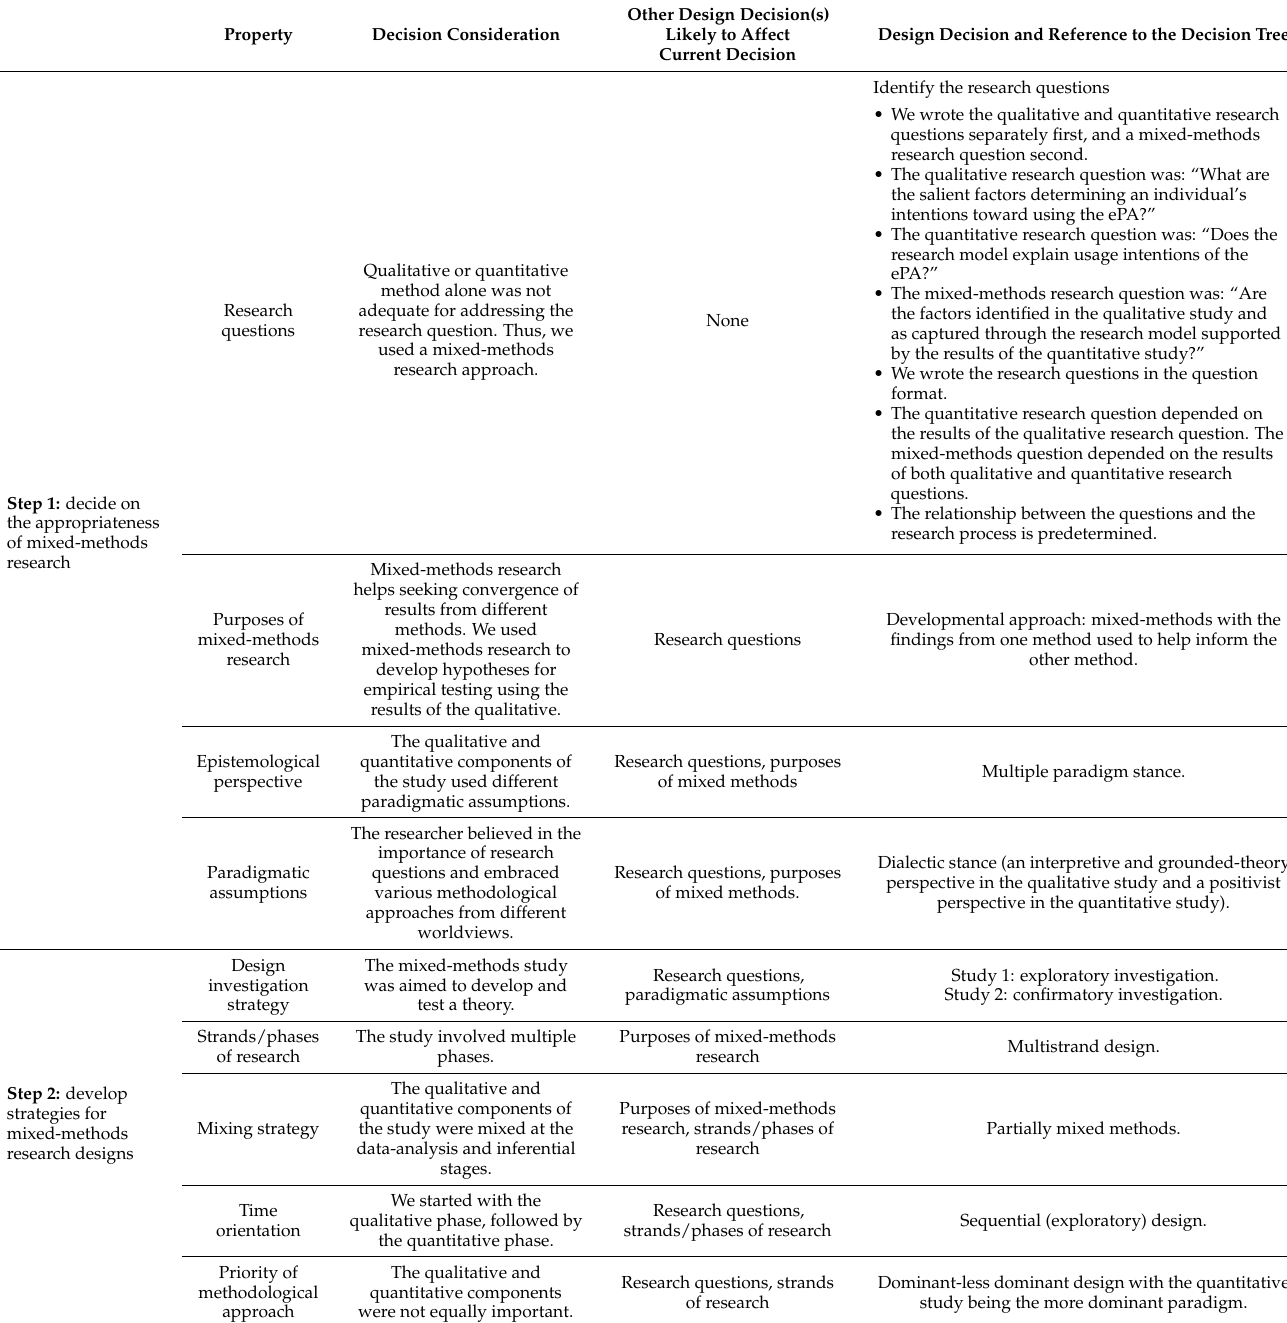
Table A1. Design Decisions for the Mixed-Methods-Design (Adapted from